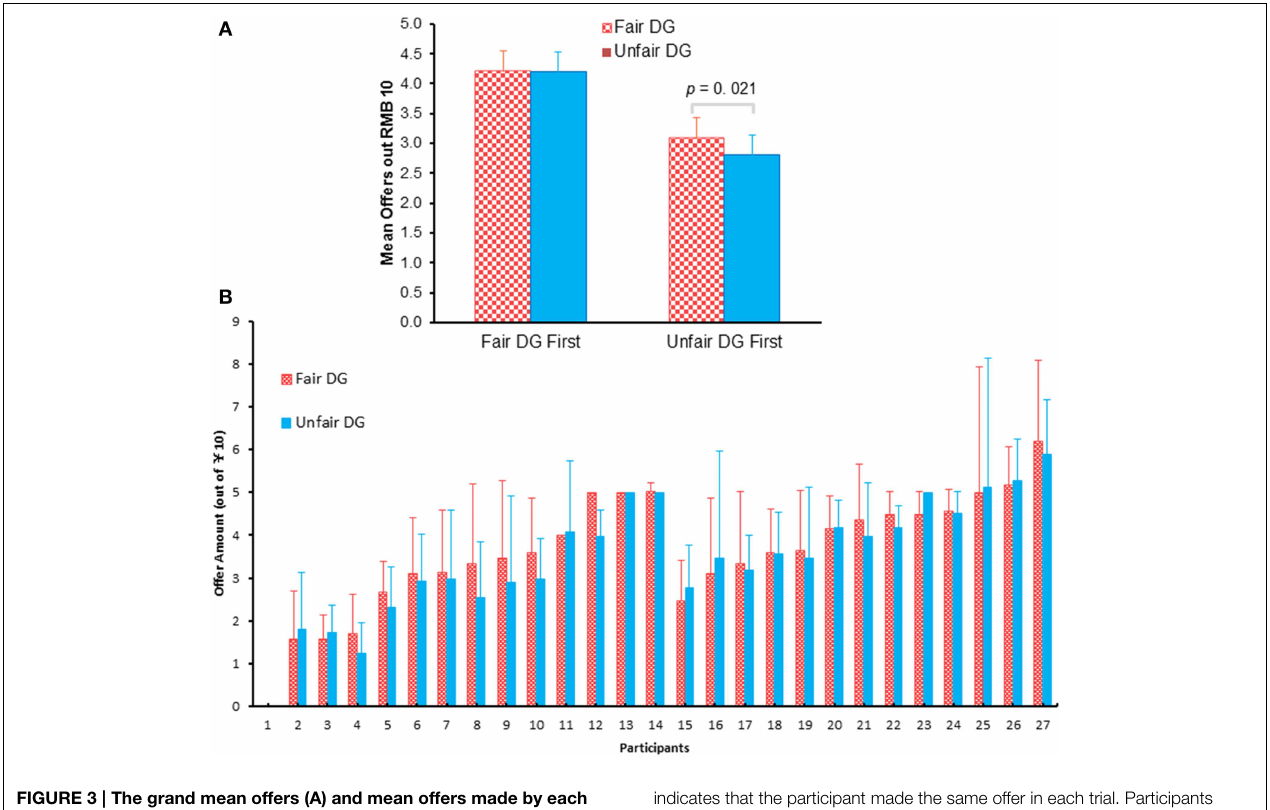
indicates that the participant made the same offer in each trial. Participants 1–14 were first exposed to unfair UG/DG and then fair UG/DG. Participants 15–27 were